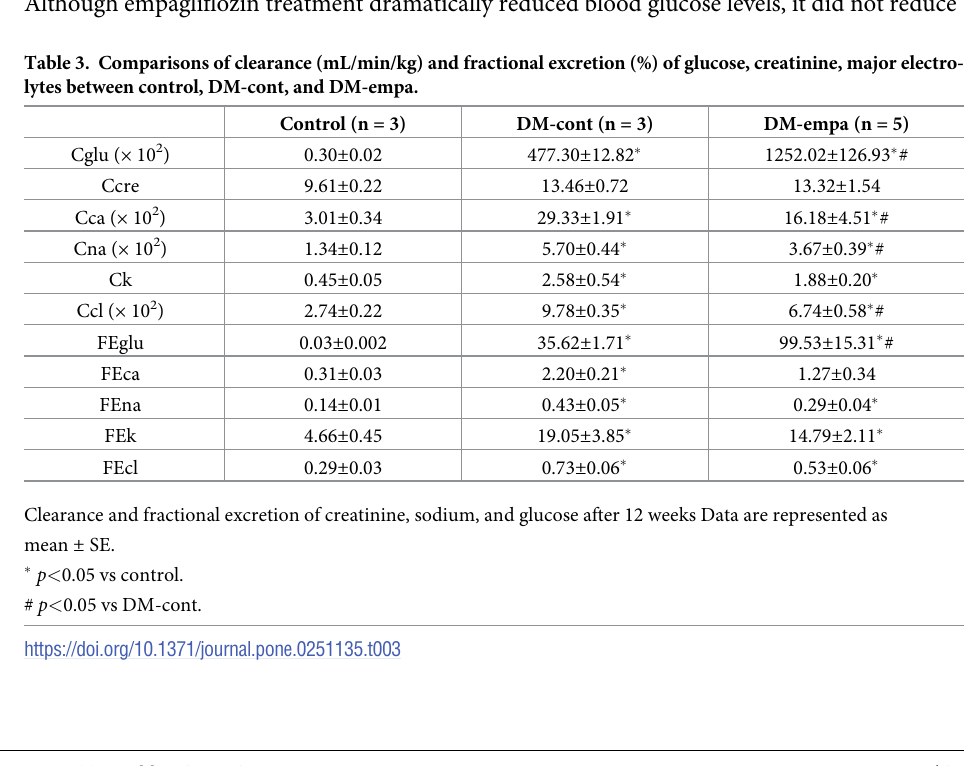
Table 3. Comparisons of clearance (mL/min/kg) and fractional excretion (%) of glucose, creatinine, major electro- lytes between control, DM-cont, and DM-empa.